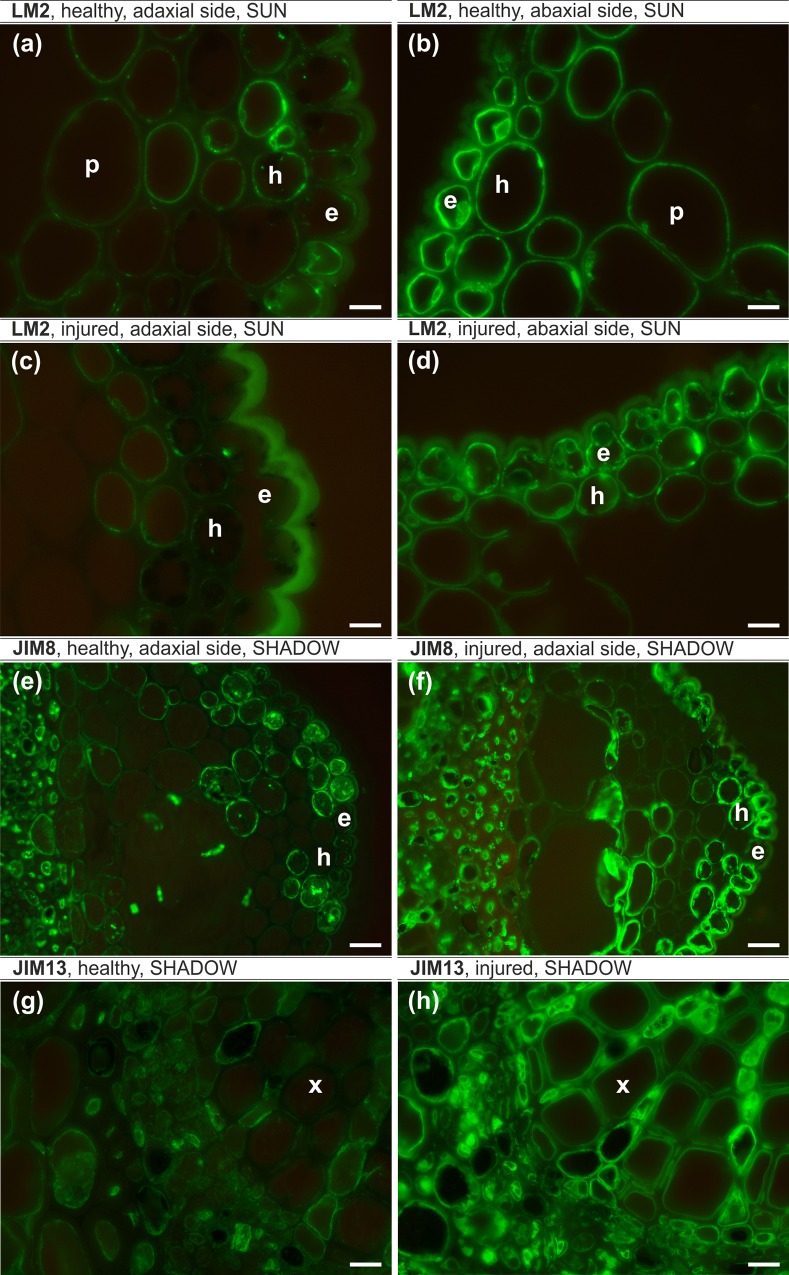
LM2 epitope, leaf lamina, sunlit side (a-d), JIM8 epitope, leaf lamina, shady side (e,f), JIM13 epitope, leaf lamina, shady side (g-h) (a,b,e,g) – healthy leaves, (c,d,f,h) – injured leaves (a,c,e,f) – adaxial side, (b,d) – abaxial side. e – epidermal cells, h – hypodermal cells, x – xylem cells. Bars, 10 μm.